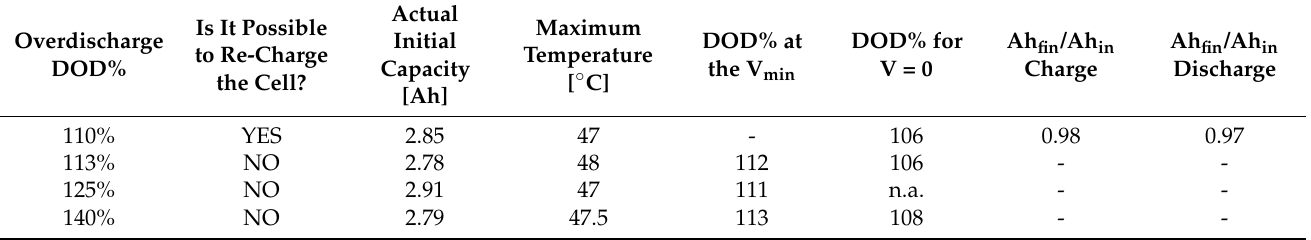
Table 2. Summary of the results obtained from the overdischarge tests on graphite-based anode cells.